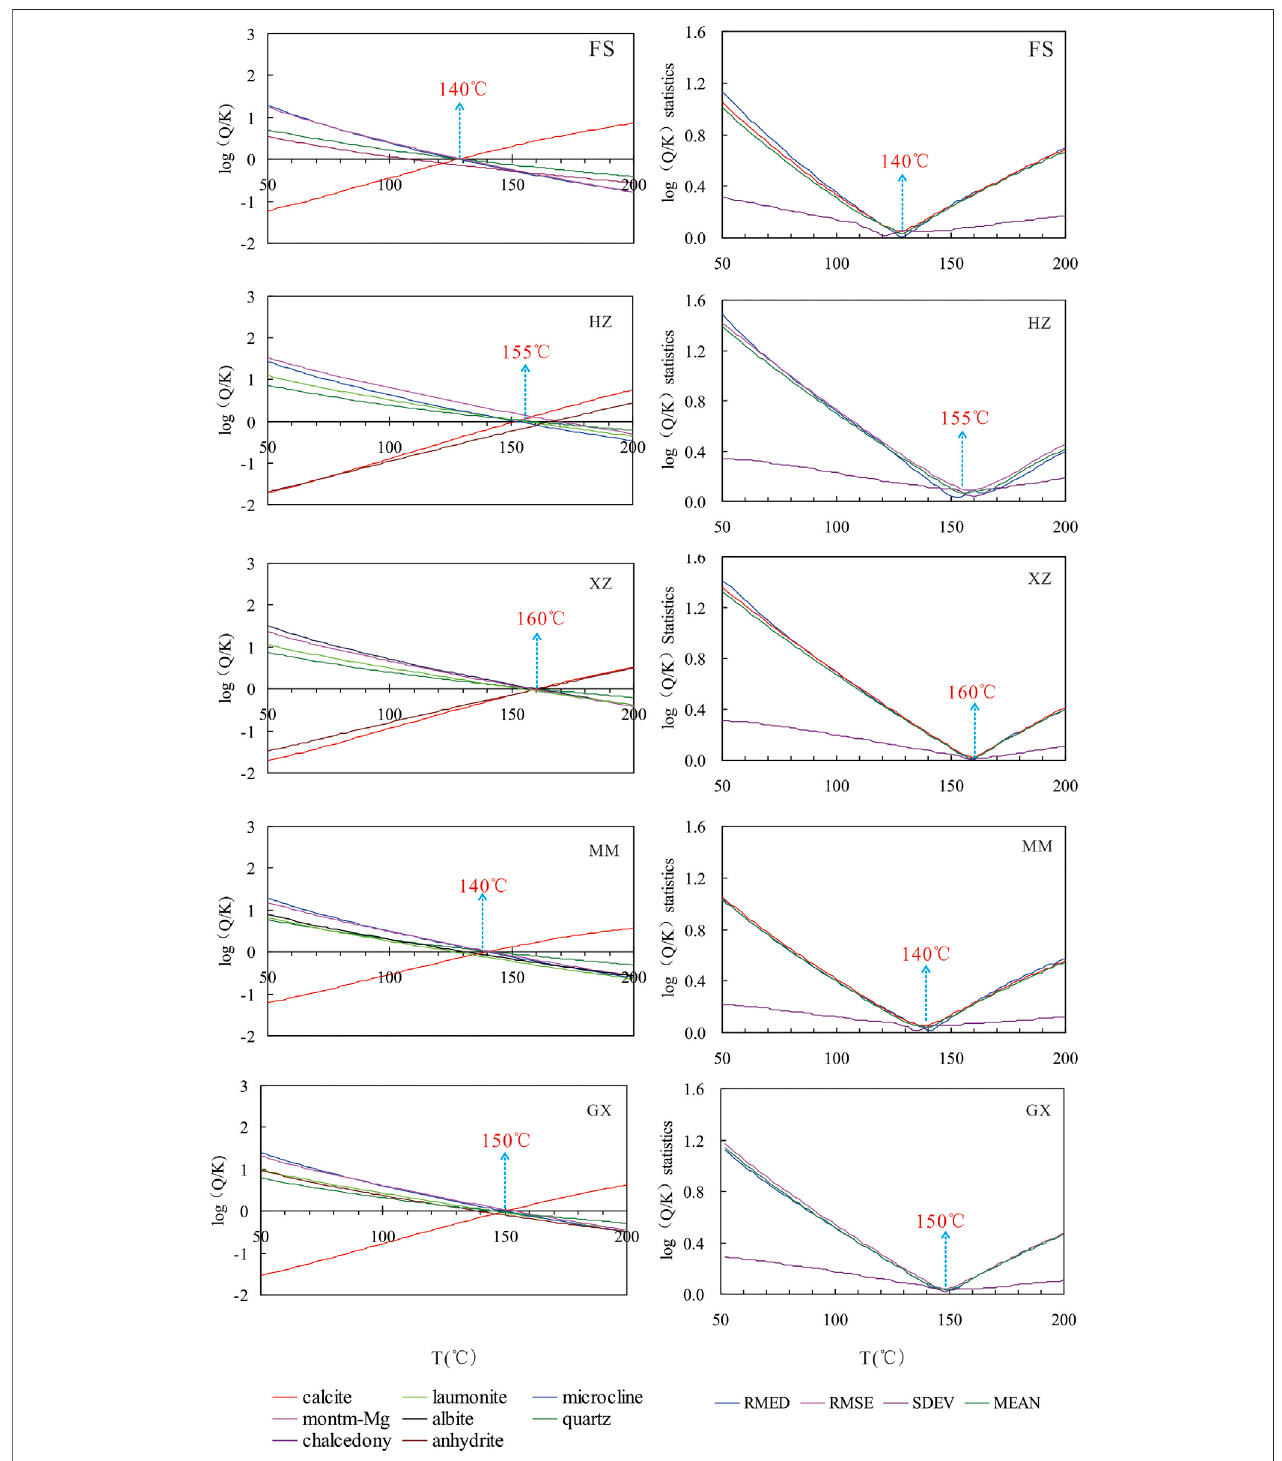
FIGURE 7 | Plot of SI of certain minerals assemblage over a temperature range of 50 – 250 ° C.